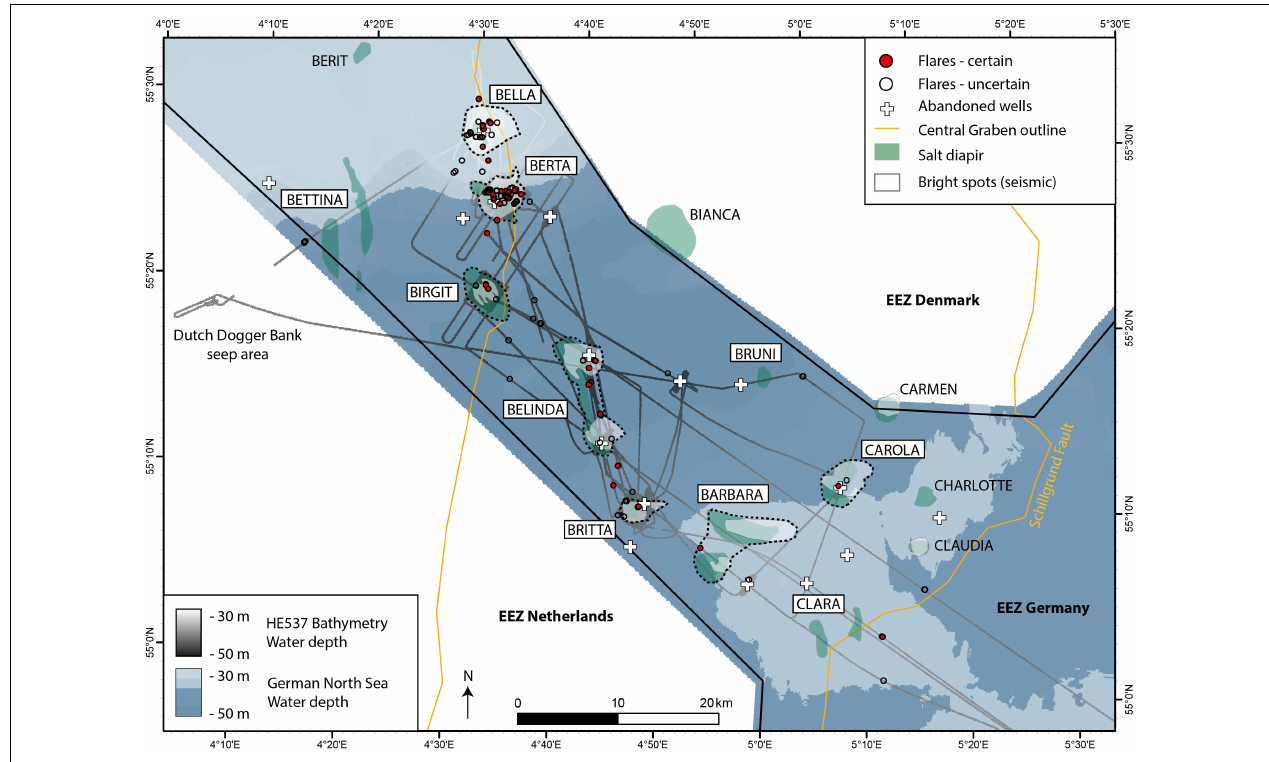
FIGURE 8 | Map compiling flare detections in relation to subsurface salt diapirs and bright spots as well as abandoned wells. Almost 90% of all detected flares were found in the vicinity of subsurface salt diapir structures [depicted from Arfai et al. (2014)]. Note that salt diapir and bright spot areas are slightly transparent to illustrate their extents where overlapping each other. Bathymetry downloaded from www.gpdn.de.